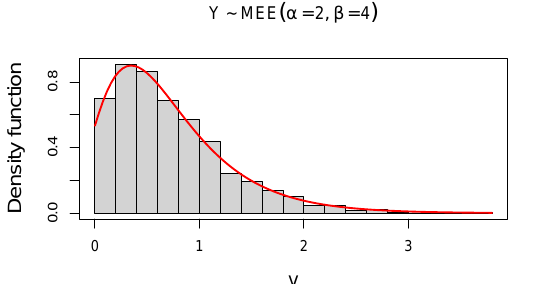
Figure 3. Histogram for the simulated study with size n = 1000 for MEE